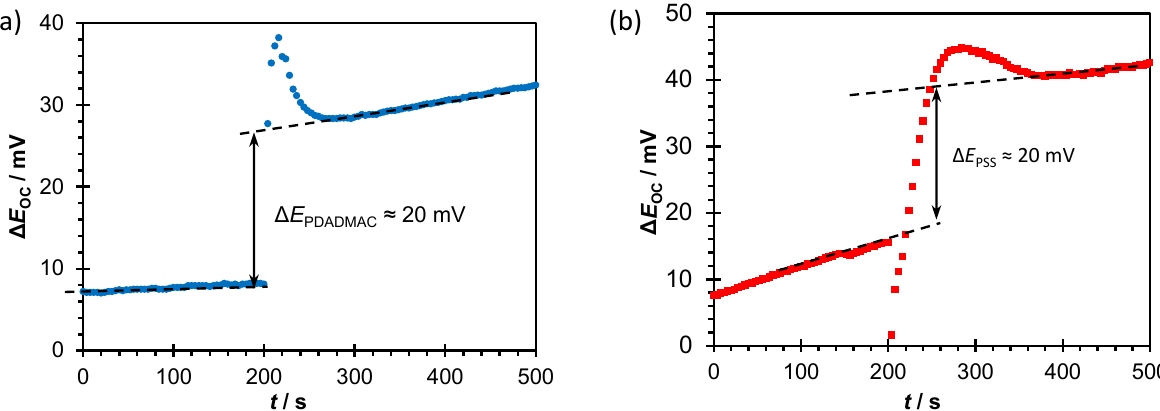
Figure 8. Electrode potential of Ti/TiO 2 -E in 0.001 mol dm –3 NaCl aqueous solution at 25 °C, before, during, and after the addition of polyelectrolyte ( a ) PDADMA, pH ≈ 11; ( b ) PSS, pH ≈ 3.